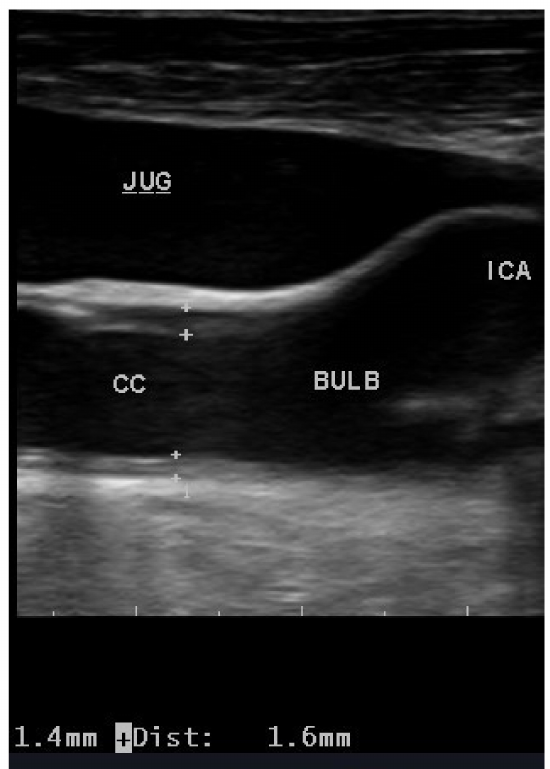
Figure 1. Increased IMT of the common carotid artery (1.4 mm far wall; 1.6 mm near wall). Legend: CC, common carotid; Bulb, carotid bulb; ICA, internal carotid artery; JUG, jugular